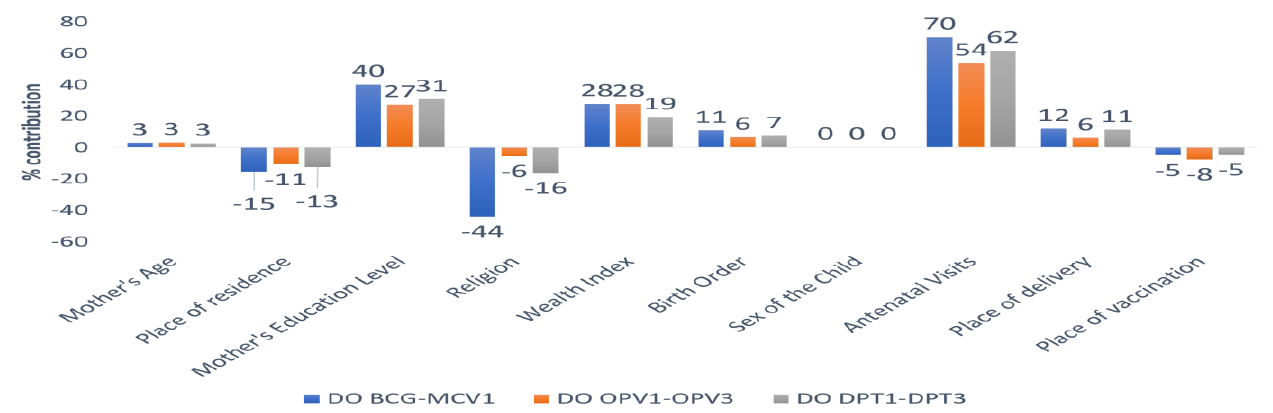
Figure 10. Percentage contribution of each covariate to the gap in dropout rates between the NFHS-4 and NFHS-5 surveys.